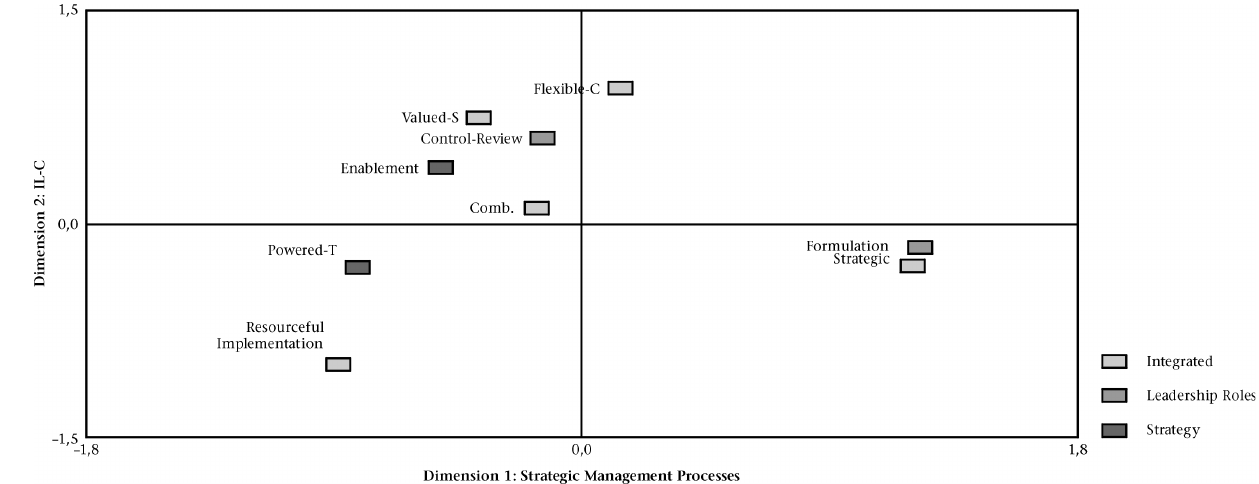
Figure 1: Bi-plot of the IL-C sub-roles and strategic management